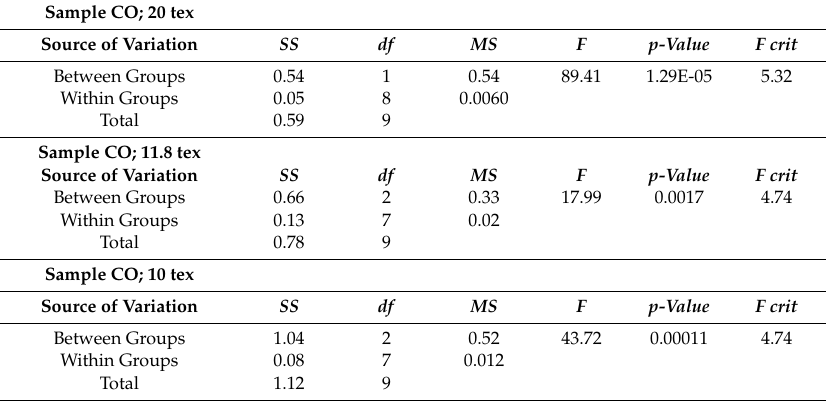
Table 10. The results of the statistical analysis of the influence of yarn twist on